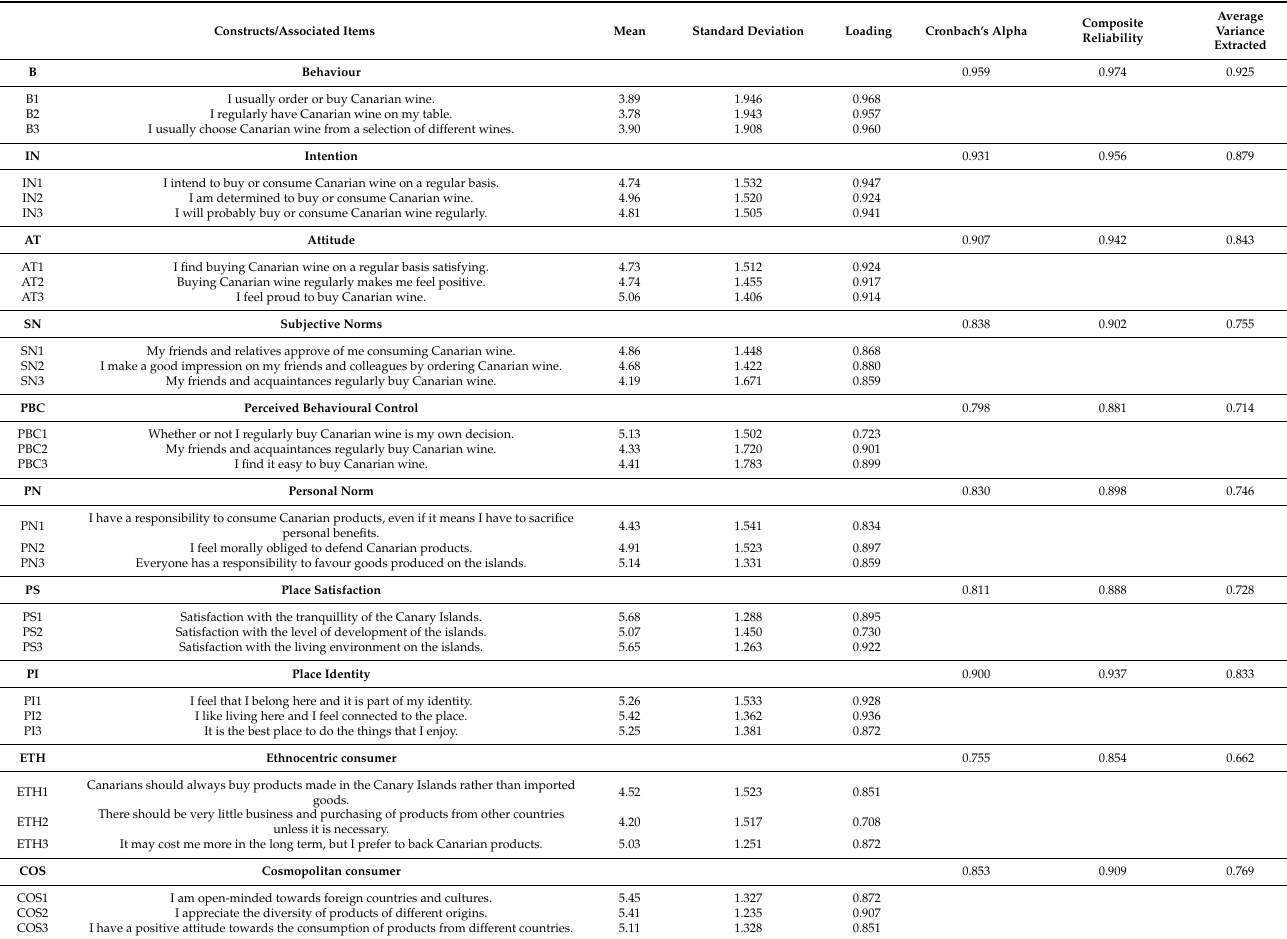
Table 2. Descriptive analysis and results of the evaluation of the measurement model.